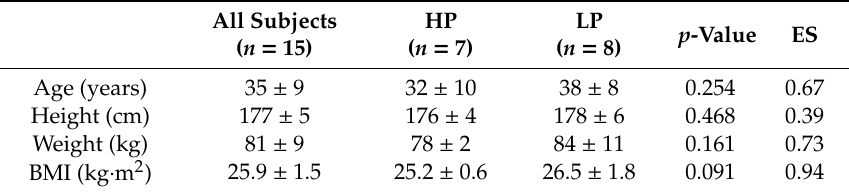
Table 1. Descriptive characteristics of study participants.